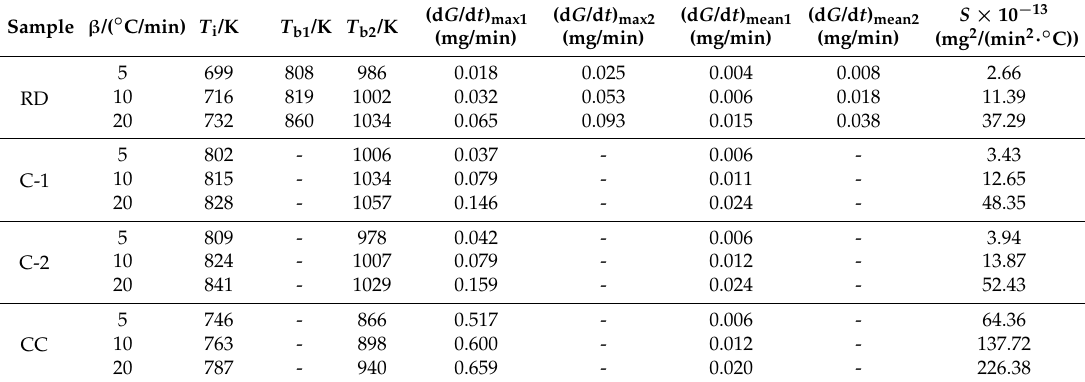
Table 4. Characteristic temperatures and comprehensive combustive characteristic index S